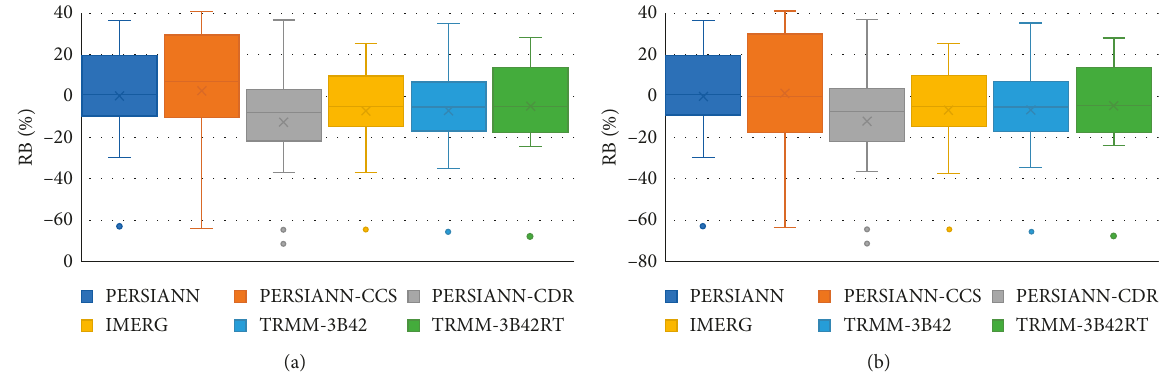
Figure 9: Results obtained from the RMSE index. (a) For Daily. (b) For